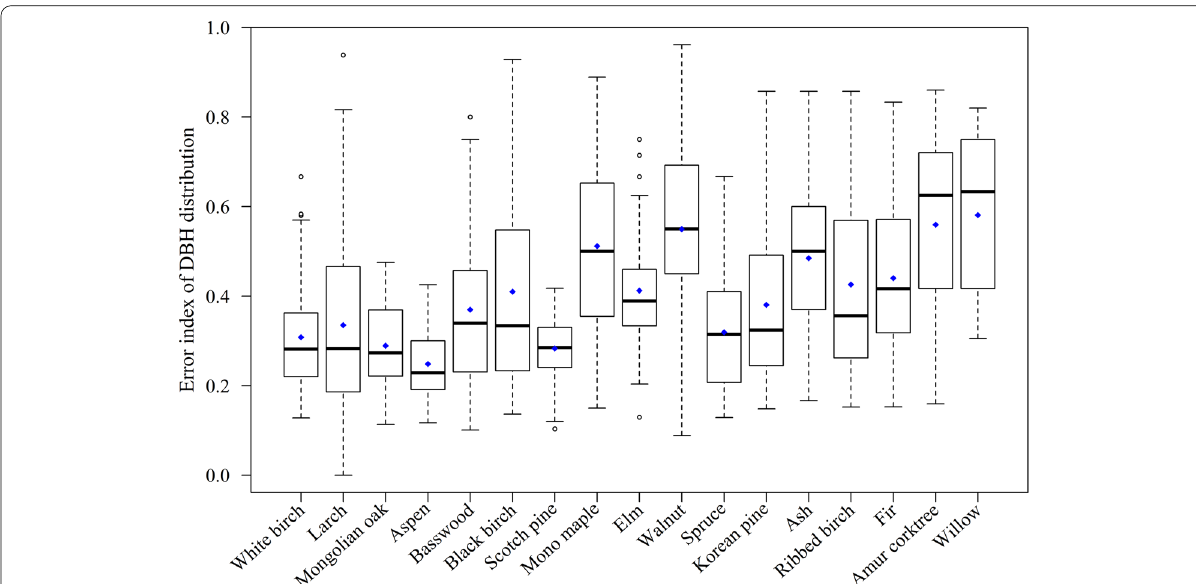
Fig. 6 Error index calculated based on the predicted wall-to-wall and transformed inventory tree lists in 2000 by species for each plot. The blue diamond represents the mean value of the error index calculated based on all